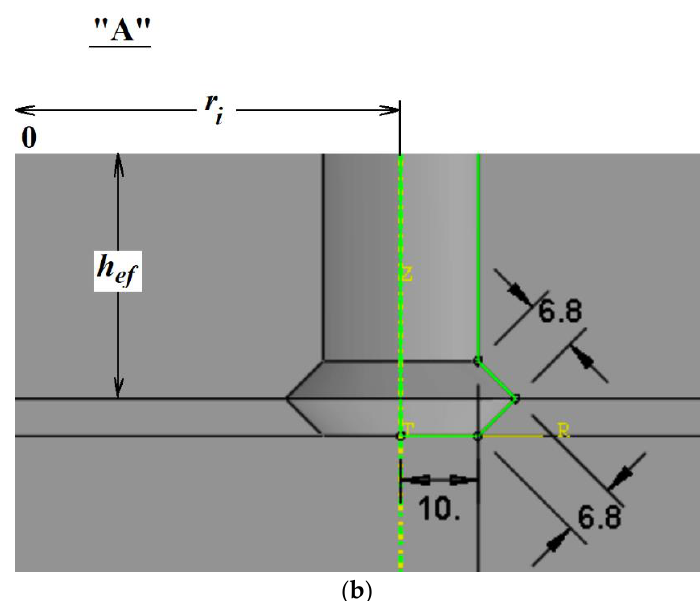
Figure 5. ( a ) The geometric model used in FEM simulation, ( b ) anchor geometry.